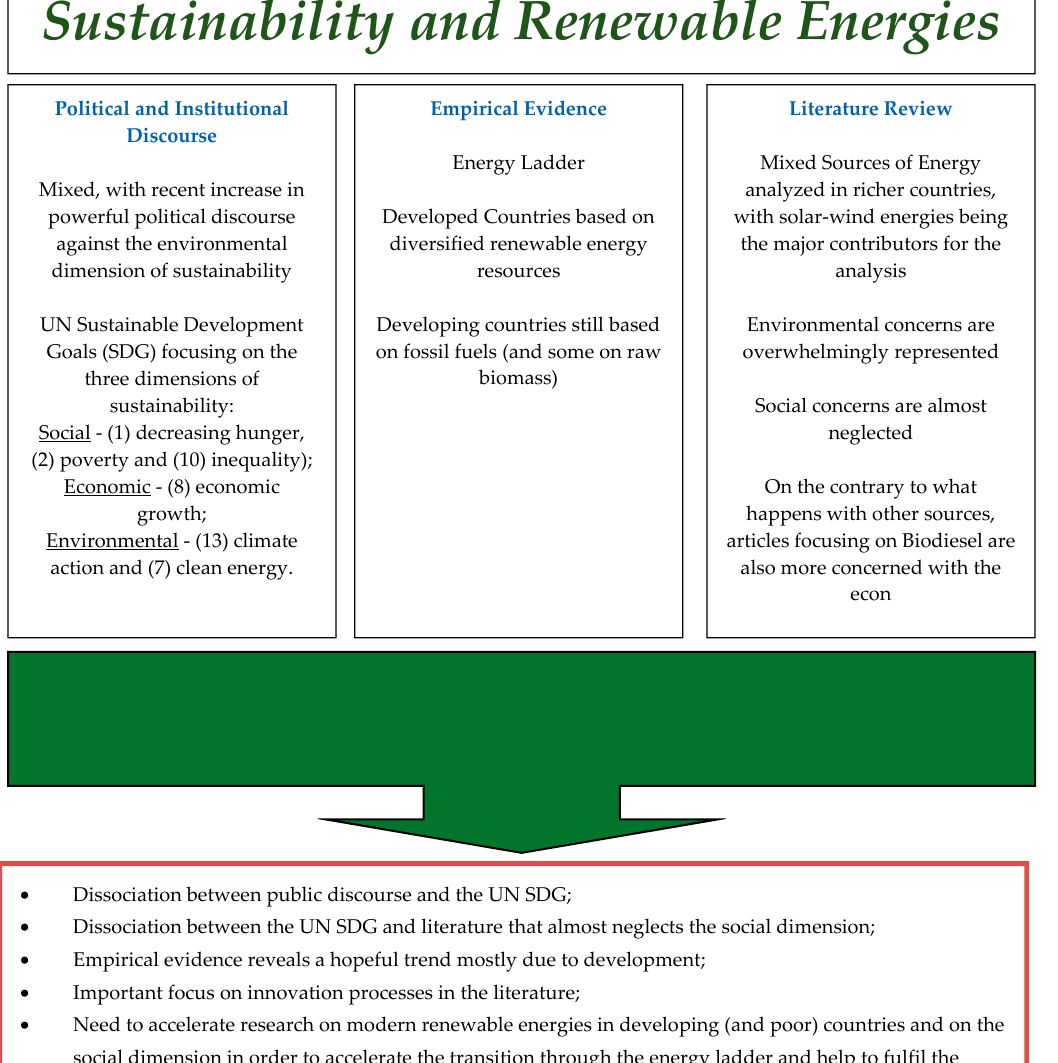
Figure 10. Summary of the critical analysis relating the findings of the article with political discourse and empirical evidence.